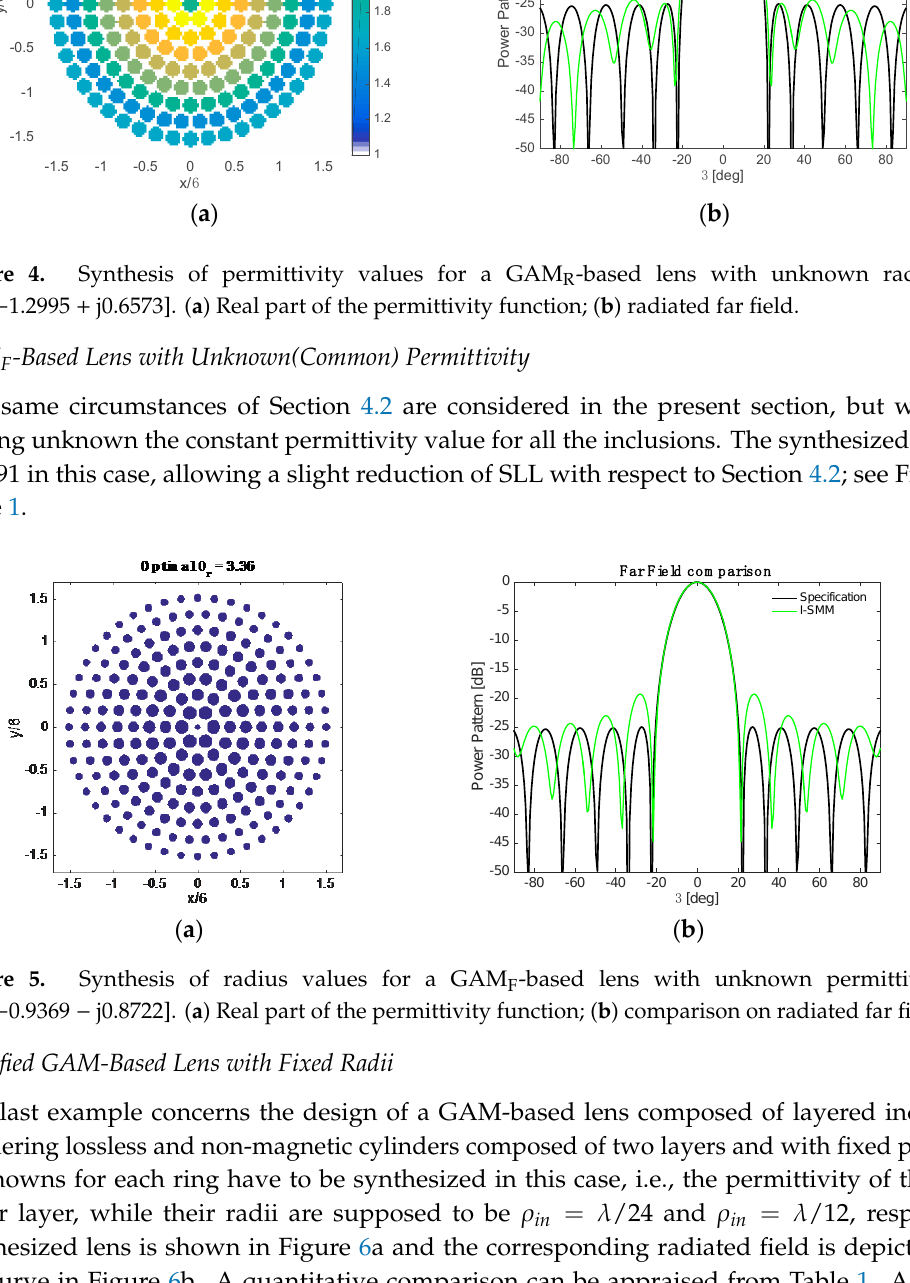
[ τ = − 0.9369 − j0.8722]. ( a ) Real part of the permittivity function; ( b ) comparison on radiated far